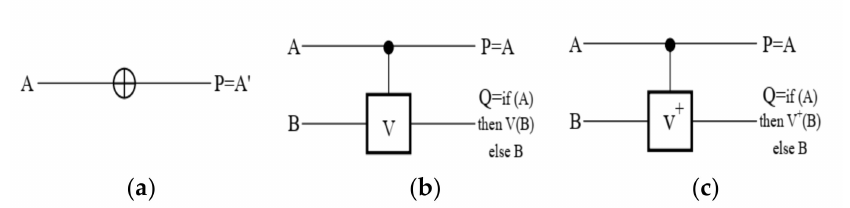
Figure 6. The quantum implementation ( a ) inverter, ( b ) control V, and ( c ) control